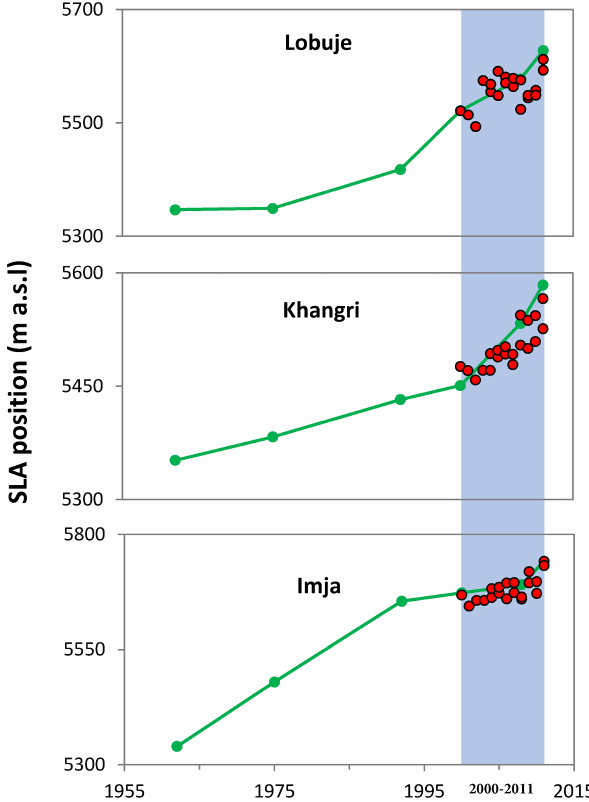
Figure 6. Validation of the SLA trend of 1962-2011 period (green line) for three selected glaciers (Lobuje, Khangri, and Imja) using the satellite imagery reported in Table 1 with additional 20 Landsat ETM + imagery (red points) of 2000–2011 period (shaded